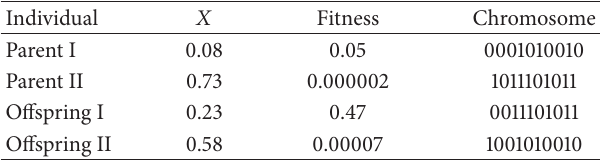
Table 8: Single mutations. Table 9: Details of